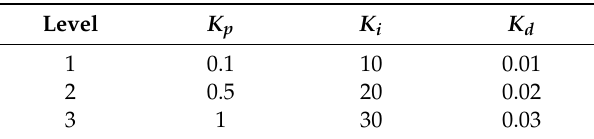
Table 6. Factor level